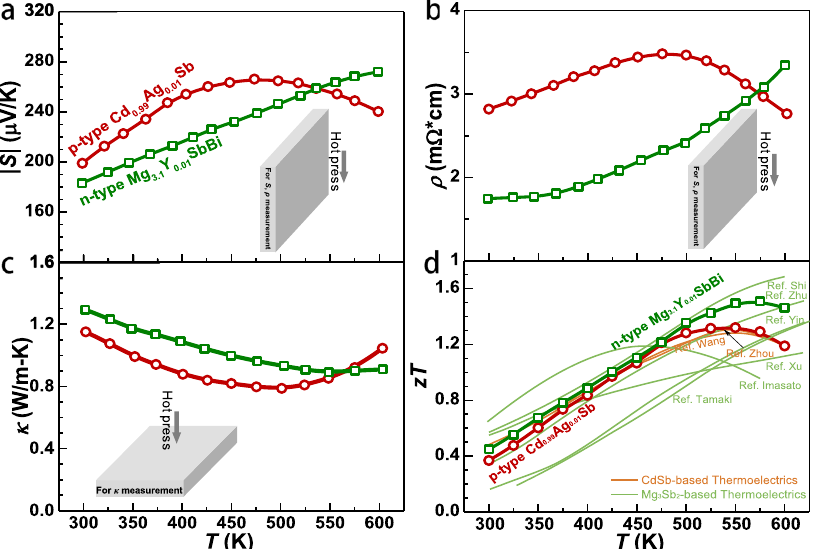
Fig. 3 Temperature dependent transport properties. Temperature-dependent Seebeck coef fi cient ( S ) ( a ), electrical resistivity ( ρ ) ( b ), thermal conductivity ( κ ) ( c ), and thermoelectric fi gure of merit ( zT ) ( d ) for n-type Mg 3.1 Y 0.01 SbBi and p-type Cd 0.99 Ag 0.01 Sb with a comparison to literature results 21,22,25,27,34,35,37,38 , where the inset schematically shows the electronic and thermal transport properties measured along the hot-press